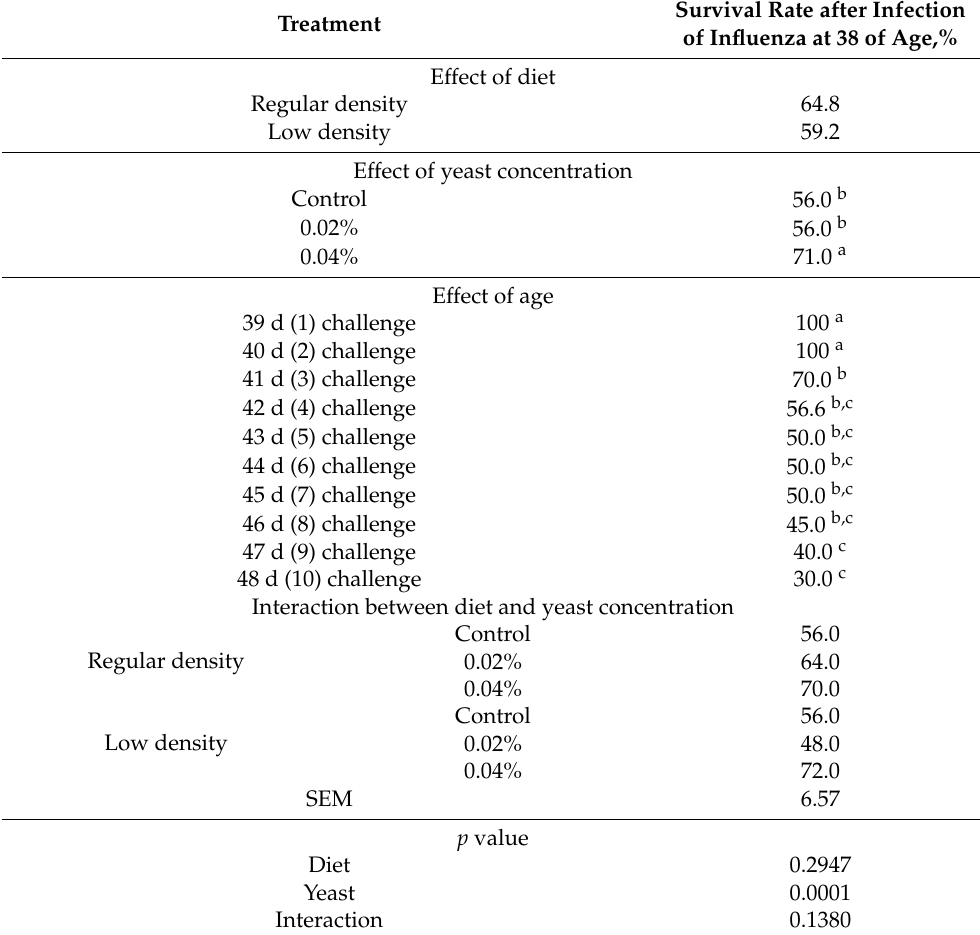
Table 8. Impact of different concentrations of Saccharomyces cerevisiae on the survival rate of broiler chickens between 38 and 48 days of age that were fed a regular- or low-density diet and infected with HPAIV H5N1 at 38 days of